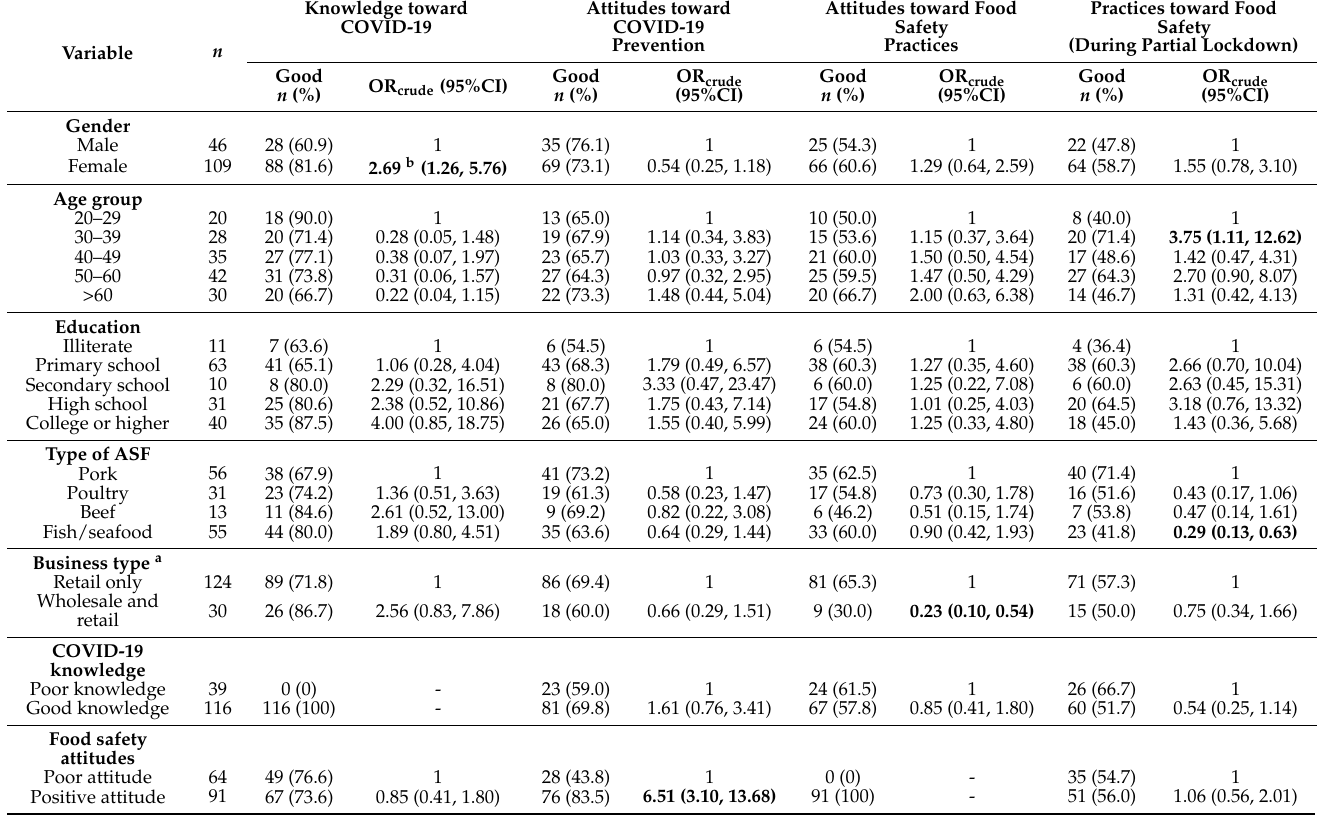
Table 2. Univariable analysis on the knowledge, attitudes, and practices of